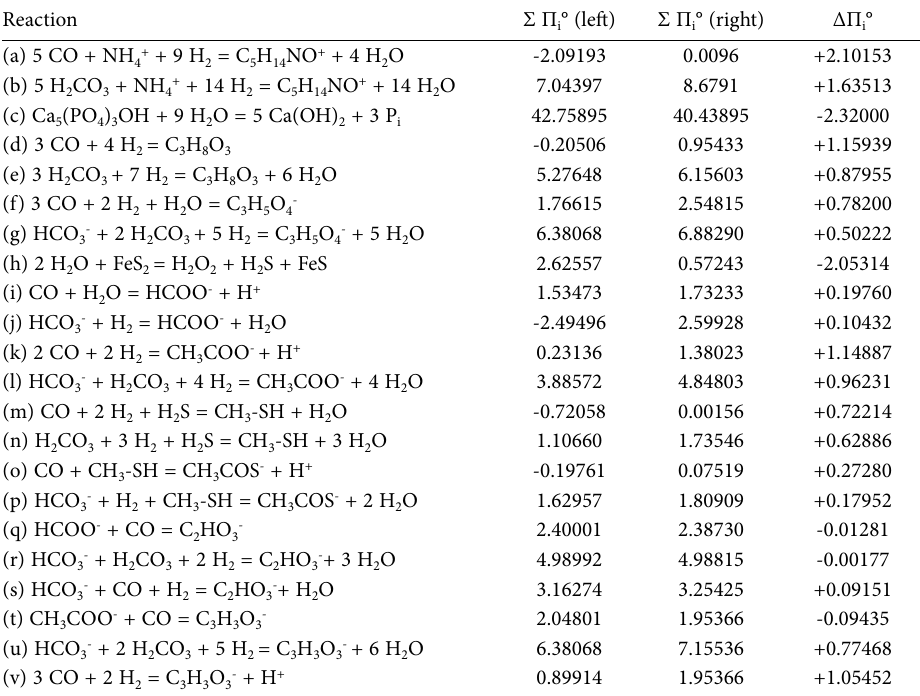
Table 5. Thermodynamic analysis of some abiotic reactions generating important compounds for the emergence of life on Earth. (a,b) Cho- line; (c) Phosphate; (d,e) Glycerol; (f,g) Glycerate; (h) Hydrogen peroxide; (i,j) Formate; (k,l) Acetate; (m,n) Methanethiol; (o,p) Thioacetic acid; (q,r,s) Glyoxylate; (t,u,v) Pyruvate. All values are given at pH = 7 and I = 0.25 M and reported in zJ·K -1 .